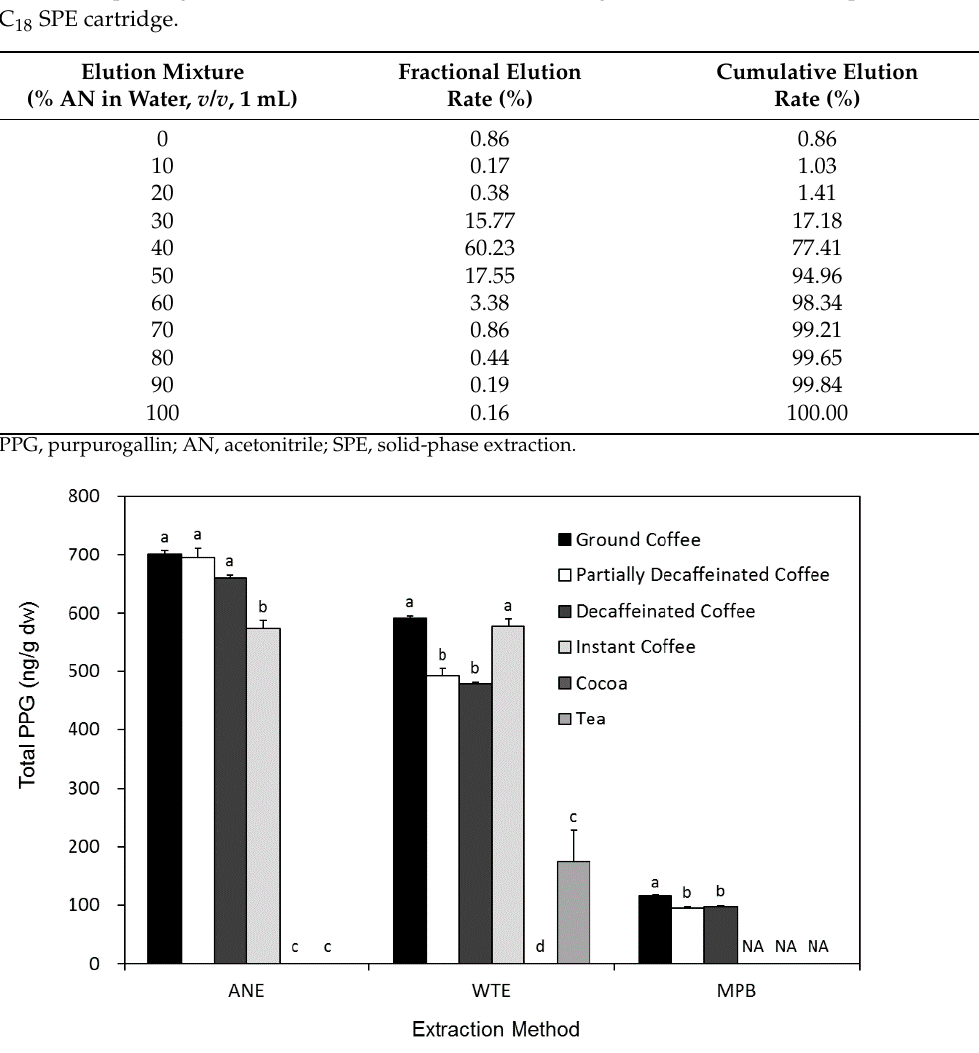
Figure 3. Effects of different extraction methods on total purpurogallin (PPG) analyzed by LC-MS. Data in each extraction method with different letters are different at p < 0.05 according to Duncan’s multiple range test, where NA denotes no data available since MPB could only be used for ground coffee samples. Data are expressed as mean ± SEM.